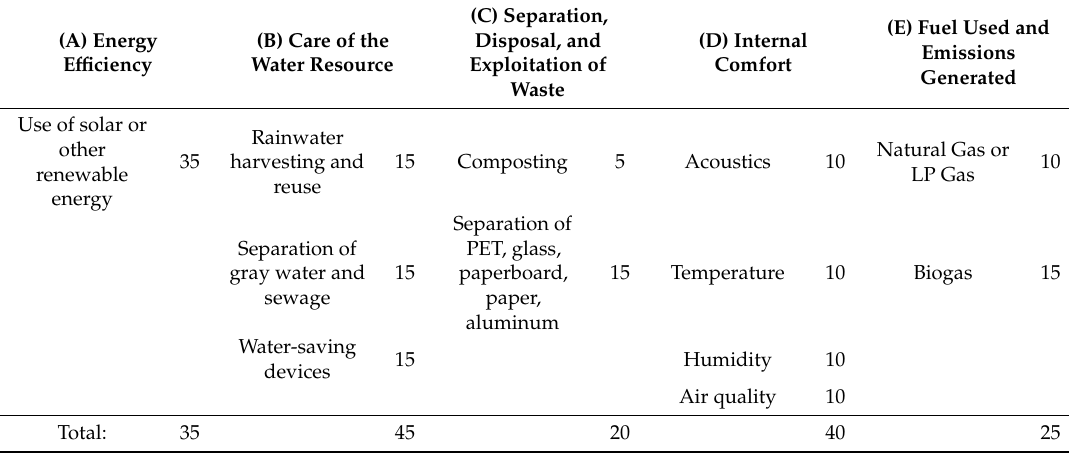
Table 2. The weight for the evaluation of the degree of sustainability for the inhabitation stage of the